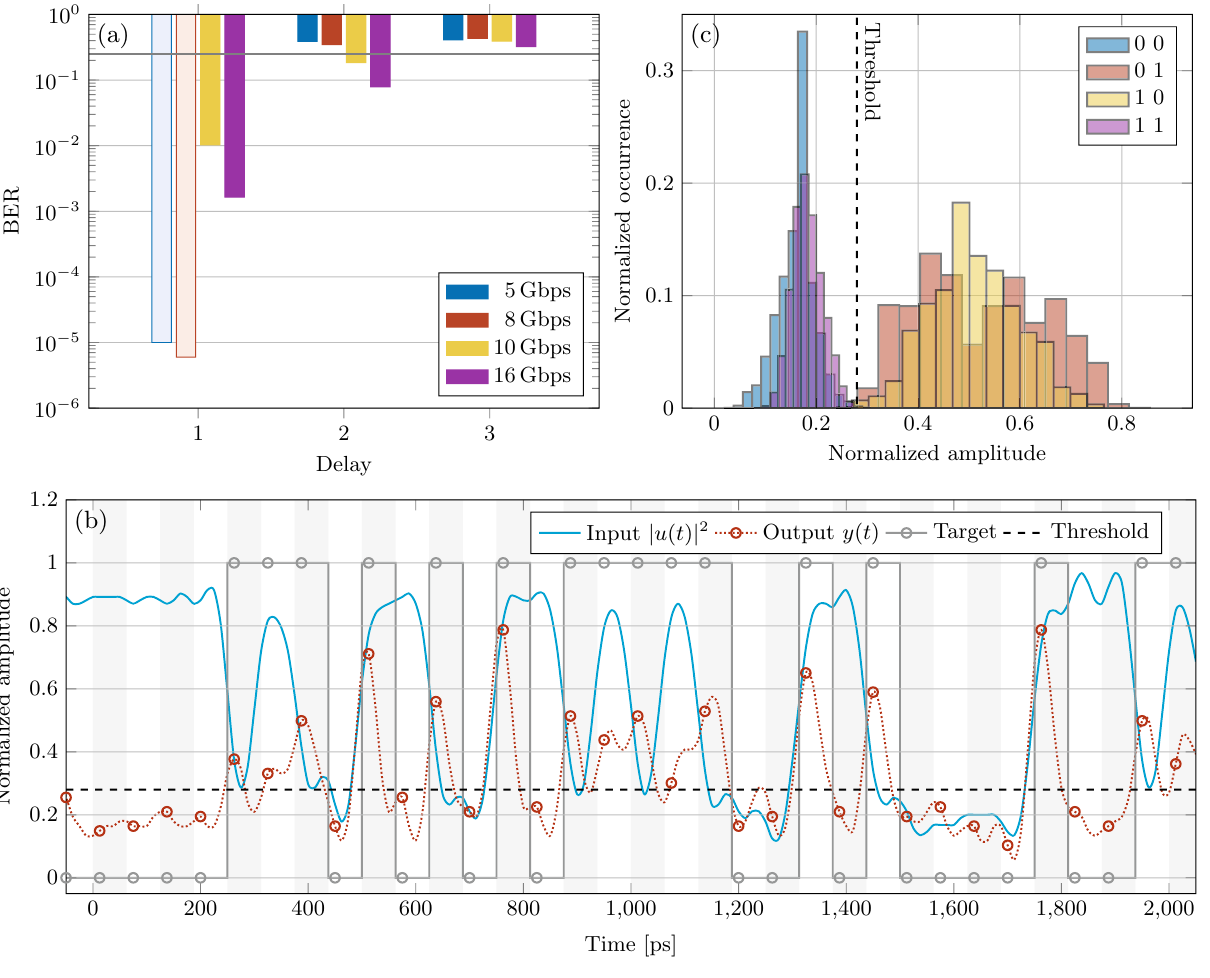
Figure 5. ( a ) BER for the several bit rates indicated in the inset and XOR bit delay. The BER is indicated with transparent bars when the statistical limit is achieved, i.e., the operation is error-free. The black line refers to the non-linear separability threshold. ( b ) Input u (blue) and output y (dashed red) time traces for a bit rate of 16 Gbps. The vertical stripes show the bit slots, the horizontal black dashed line indicates the optimal threshold while the red dots the optimal sampling time. Gray dots mark the target. ( c ) Output signal levels distribution of the 2nd bit of the 2-bit patterns given in the inset. The vertical dashed line marks the optimal threshold. ( b,c ) Refer to a bit rate of 16 Gbps. Training and test are carried out at best sampling and threshold